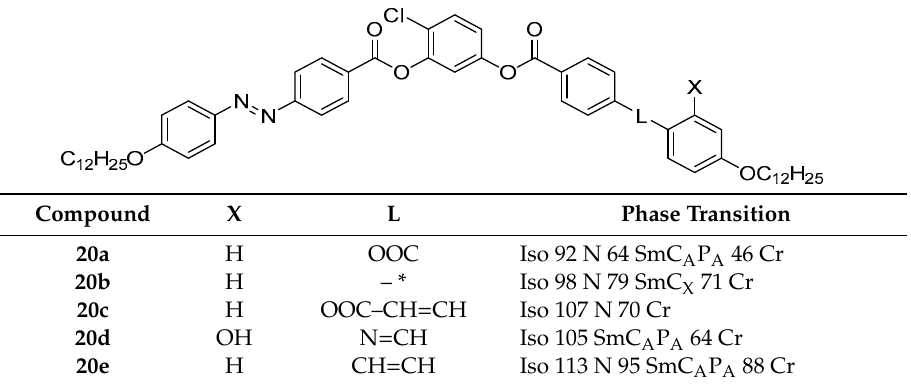
Table 4. Phase transition of compounds of series 20 .